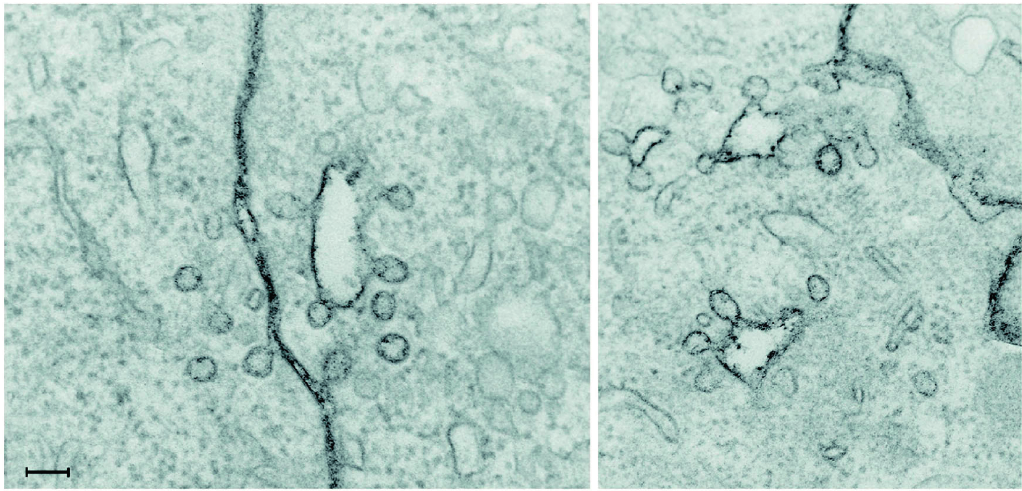
Figure 2. Electron microscopy image taken after staining of the plasma membrane with ruthenium red added during the fixation. Some of the structures revealed by this staining to be plasma membrane connected might otherwise have been interpreted as being intracellular vesicles. The scale bar is 100 nm. Reproduced from